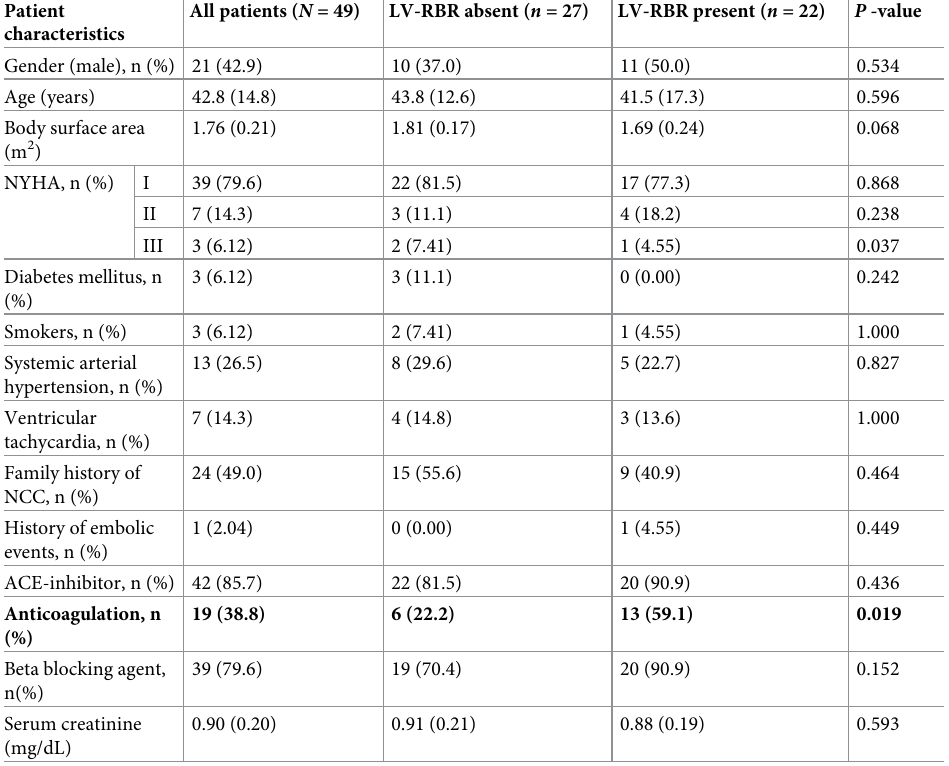
Table 1. Demographic, clinical, and laboratory data of noncompaction